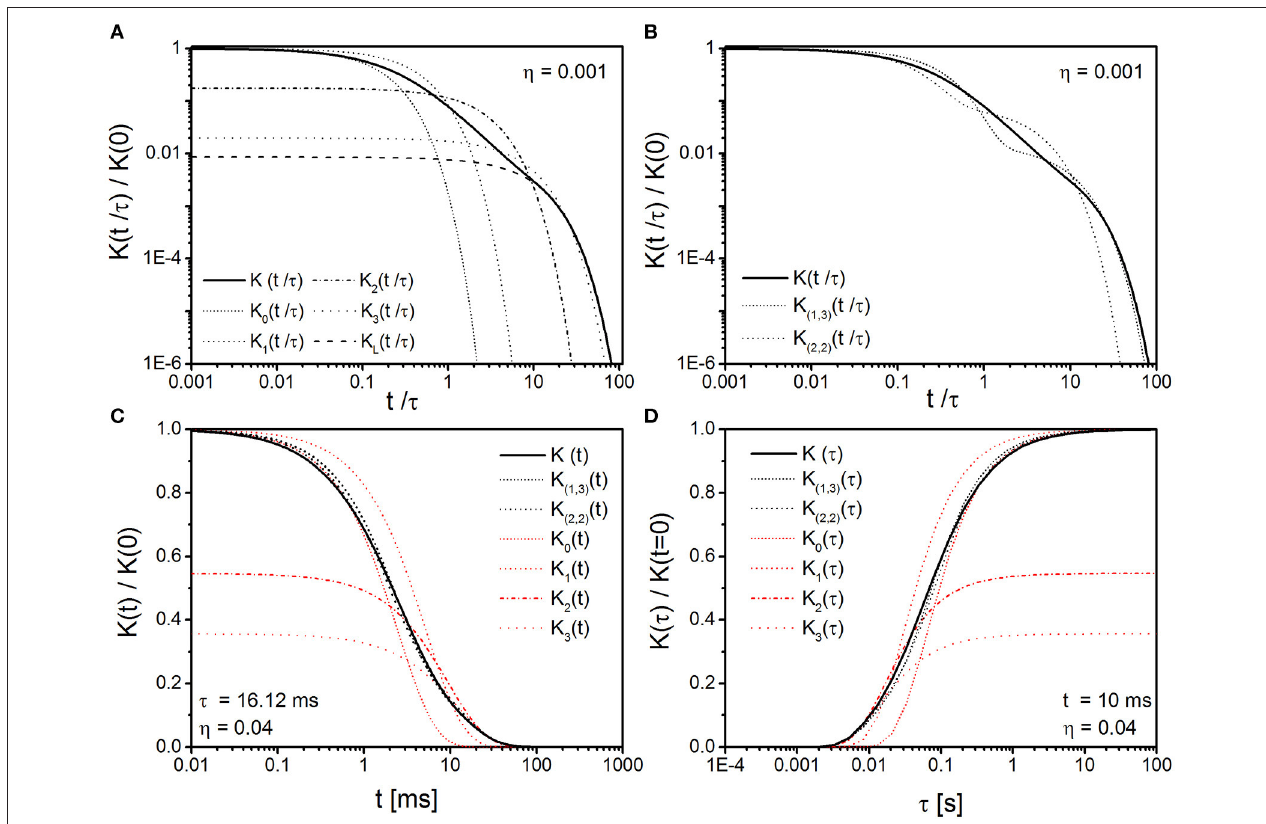
FIGURE 4 | Mono- and bi-exponential approximation in the GMA of spherical objects. (A) Monoexponential approximations K i ( t ) of the correlation function K ( t ) (solid line) as obtained from Equation (B3) with moments given in Schulten et al. [ 46]. The long time approximation K L ( t ) (dashed line) is given by Equation (20) where the first eigenvalue κ 1 is determined by Equation (17) ( η 0.001 in A,B ). (B) Biexponential approximations for long times K (1,3) ( t ) [dashed line obtained from = Equation (39)] and for short times K (2,2) ( t ) [dotted line obtained from Equation (37)] of the correlation function K ( t ) [solid line obtained from Equation (14)]. Evidently, for spherical objects, the biexponential approximations are more accurate than monoexponential approximations and show a better agreement for large and short times with the actual correlation function K ( t ). (C) Mono- and bi-exponential approximations of K ( t ) for typical parameters of iron-storage in oligodendrocytes of the Globus pallidus, see main text for details. K (1,3) ( t ) and K (2,2) ( t ) both show an excellent agreement with K ( t ) whereas the monoexponential approximations exhibit significant deviations from K ( t ) for t . 30ms. (D) Correlation function approximations in dependence on correlation time τ at time-point t 10ms for otherwise equal = parameters as in (C) . The agreement of biexponential approximations with K ( t ) is excellent for all correlation times, whereas the monoexponential approximations mainly agree with K ( t ) for very short or very long correlation